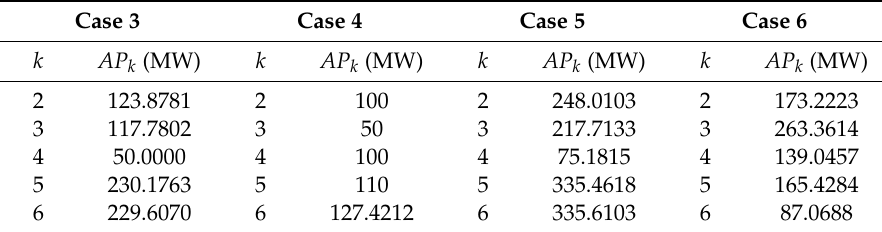
Table A2. The best solutions for system 2 found by MSFS.